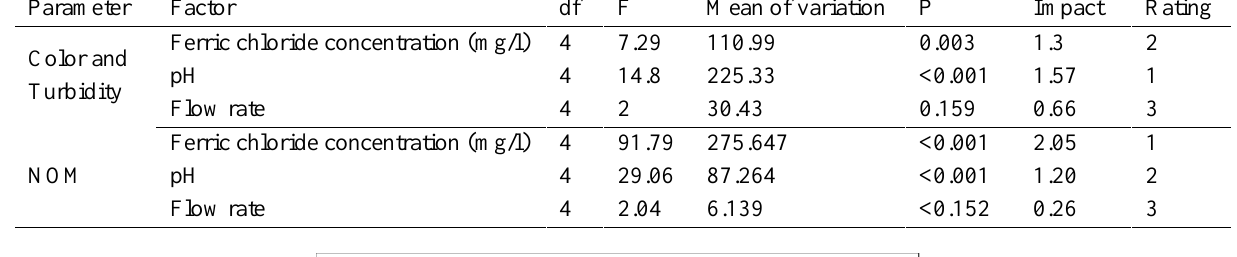
Table 2. Analysis of variance for the effect coagulant dose, pH and flow rate on removal of color, turbidity and NOM Parameter